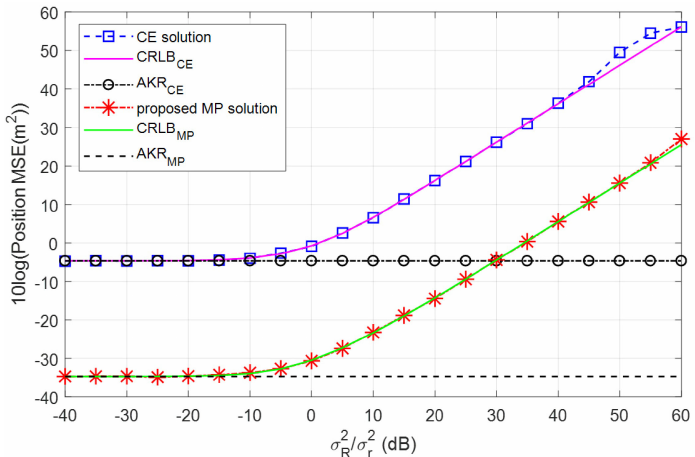
Figure 5. Performance of a near acoustic target and a far calibration